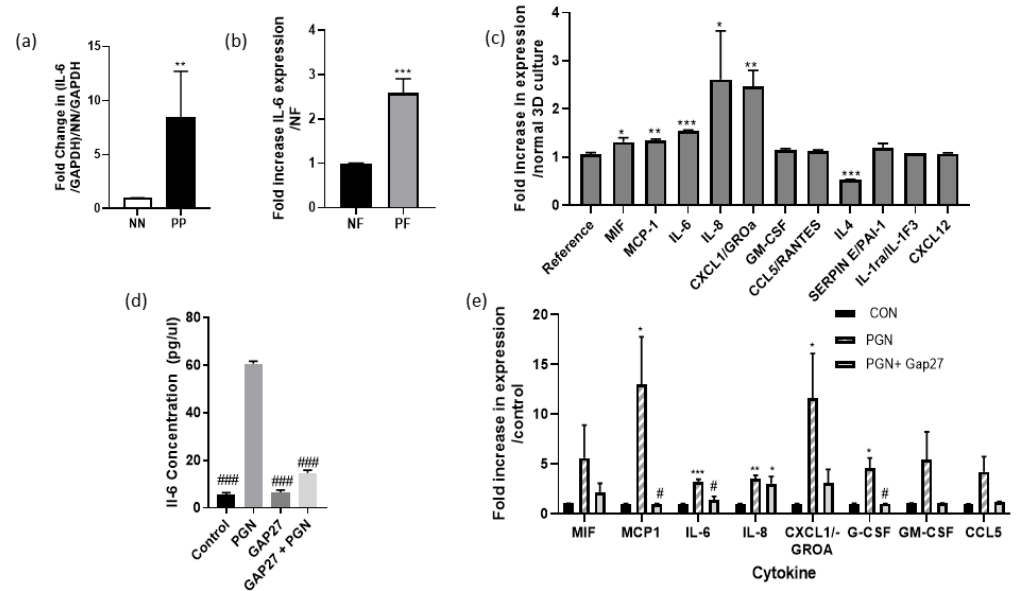
Figure 6. Psoriatic fibroblasts have an increased pro-inflammatory profile that can be reduced by connexin mimetic peptide Gap27. ( a ) RNA was extracted from NN and PP tissue biopsies and subject to RT-PCR analysis to assess IL-6 gene expression ( N = 6 biopsies per patient); data are expressed as the fold change in IL-6 expression compared to normal tissue. ( b ) Media was collected from NF and PF cells and subject to ELISA assay for IL-6 ( N = 6); data are expressed as the fold increase in IL-6 protein expression compared to NF. ( c ) Following 12 days at the ALI and generation of the 3D organotypic model the media was collected and subject to a RnD cytokine array. The relative change in cytokine expression PF vs. NF cultures was compared ( N = 3). Statistical analysis was performed via two-tailed t -test to determine significance compared to NN or NF samples ( a , b ) or to the reference controls on the arrays that were unaltered between samples ( c ). * p < 0.05, ** p < 0.001; *** p < 0.0001. ( d , e ) NF were subject to 24 h exposure to 10 µ g/mL PGN in the presence or absence of 100 nM Gap27 and the collected media was subject to ( d ) IL-6 ELISA assay ( N = 6) or ( e ) to a R&D cytokine array where the fold change in cytokine protein expression over control was determined ( N = 4). One-way ANOVA followed by Dunnett’s multiple comparison determined the significant differences between ( d ) PGN challenged with control and PGN+Gap27 # p < 0.05, ### p < 0.001 and ( e ) within each cytokine group to the control * p < 0.05, ** p < 0.001; *** p <